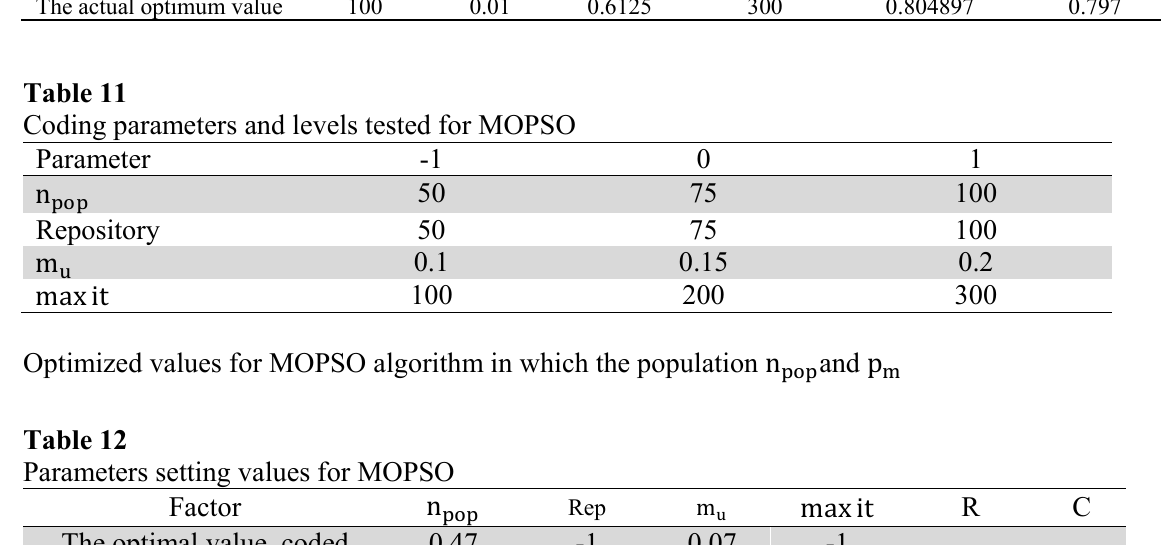
Parameters setting values Factor (cid:1814) The optimal value, coded The actual optimum value